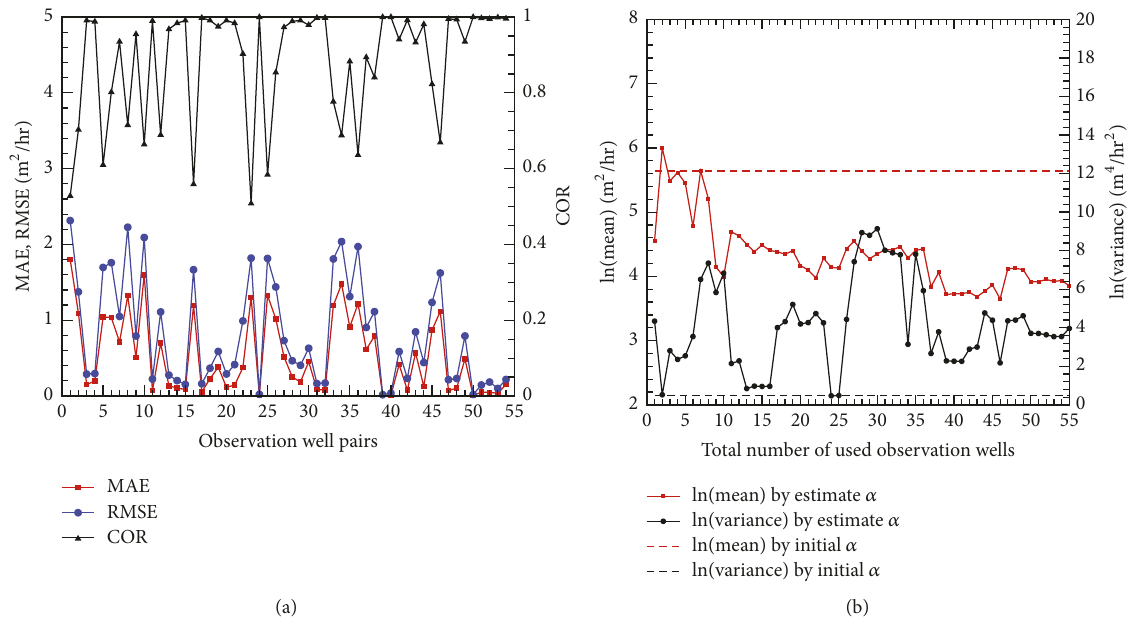
Figure 11: Total number of used observation wells for investigating the estimated heterogeneous 𝛼 field results in the real aquifer. (a) Error and correlation graph of the estimated 𝛼 obtained from the current observation well and its following (observation well pair); (b) the ln(mean) and ln(variance) graph of the estimated 𝛼 and initial 𝛼 .